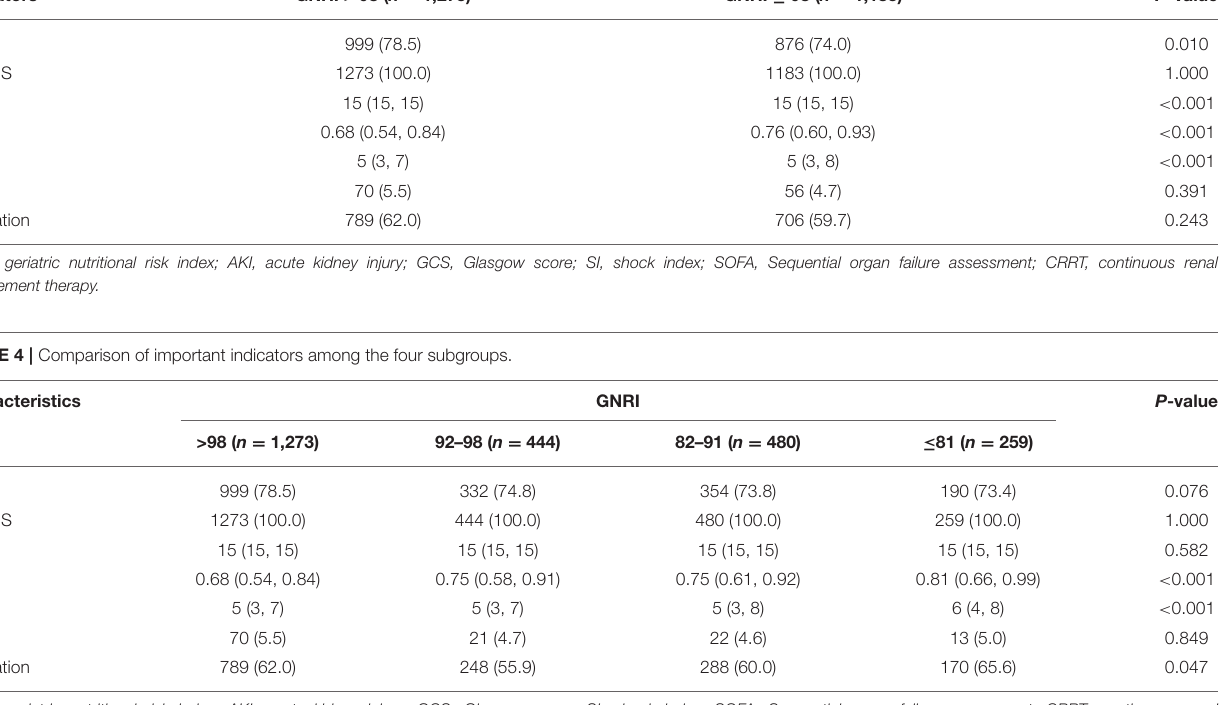
TABLE 3 | Comparison of the conditions of patients in the normal and malnutrition groups. Indicators